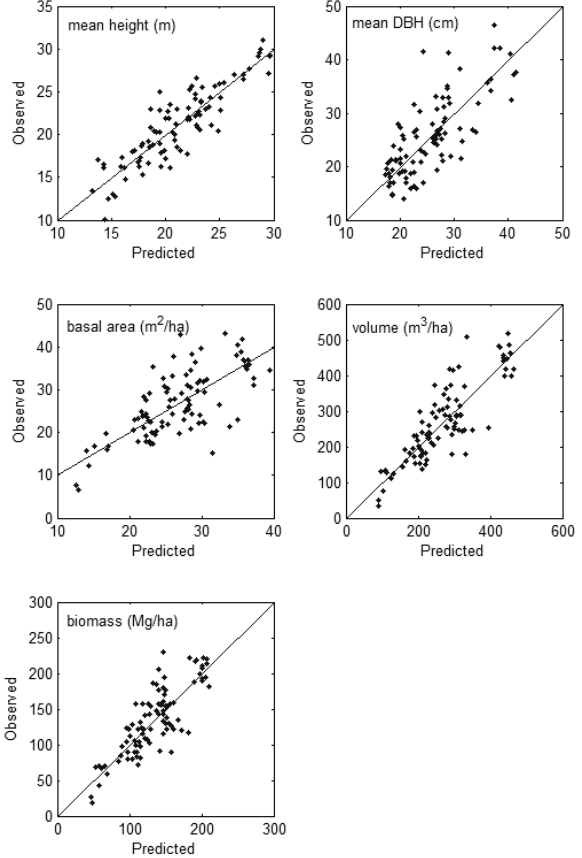
Figure 4. Scatter plot of predicted value versus observed value for TDX data. Line in the figure is one-to-one line.